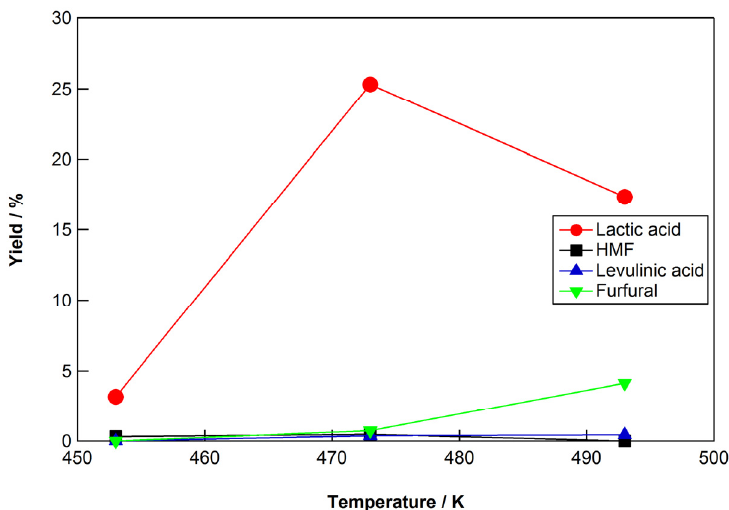
Figure 4. Product yields obtained when 10%ZrO 2 –Al 2 O 3 was used as the catalyst as a function of reaction temperature. Reaction conditions: ball ‐ milled cellulose, 0.5 g; catalyst, 1.0 g; water, 50 g; reaction time, 6 h. HMF, 5 ‐ hydroxymethylfurfural.